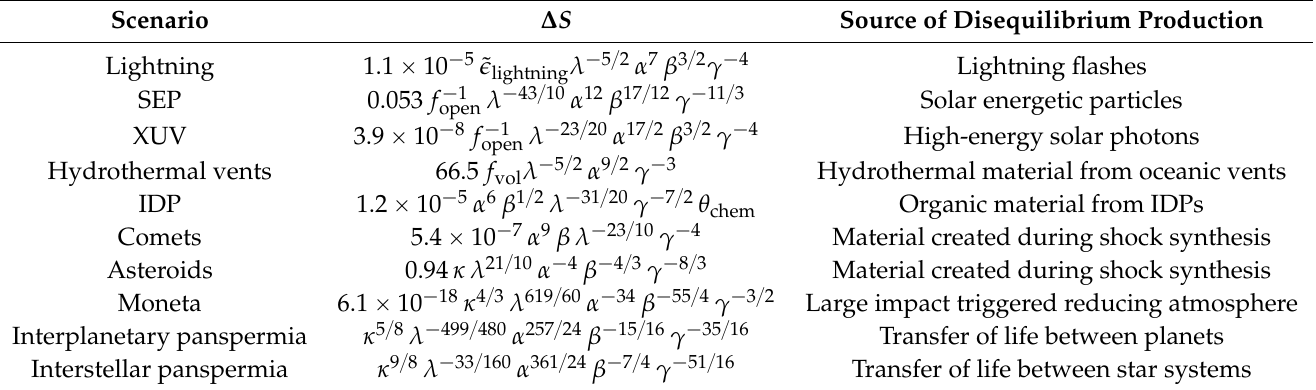
Table 1. Disequilibrium production for the different origin of life scenarios considered. For scenarios where we expect deviations from the ansatz p life 9 ∆ S (the Moneta and panspermia scenarios, see main text), an effective ∆ S is presented as the factor which modifies the usual probability